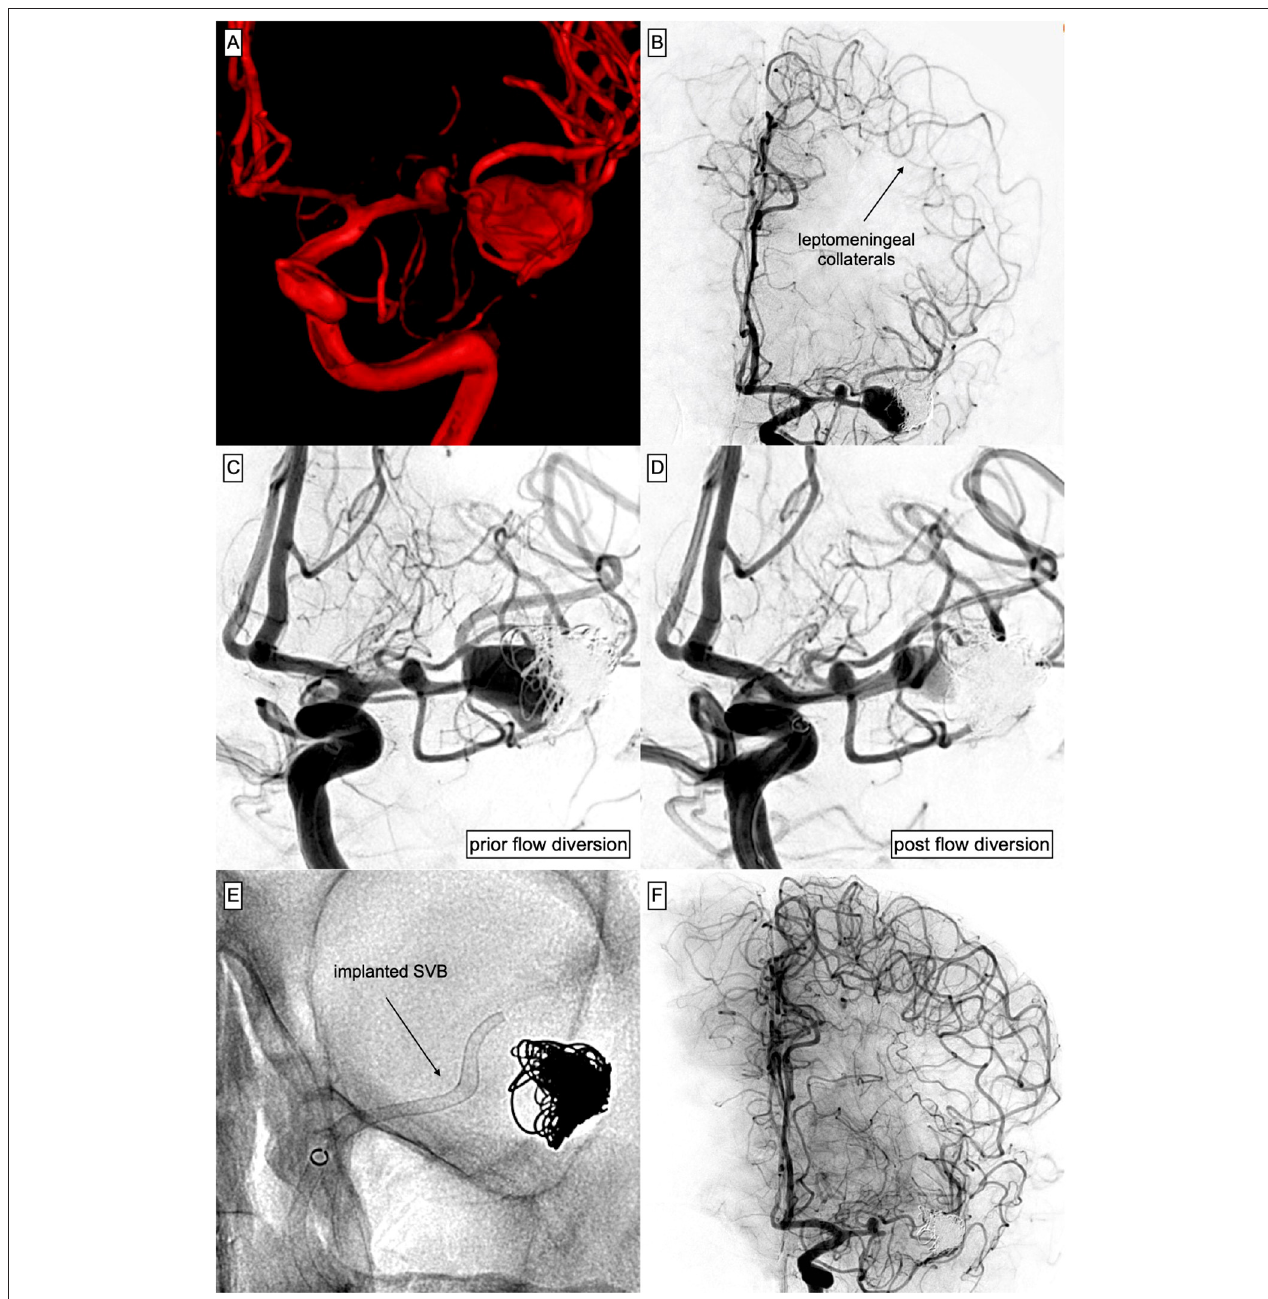
FIGURE 2 | Complex course of a ruptured aneurysm arising from the MCA-bifurcation, treated with Plug & Pipe. (A) 3D reconstruction of the acutely ruptured, complex MCA-bifurcation aneurysm measuring 10mm × 18mm. (B) DSA 3 weeks after protective coiling of the ruptured aneurysm aiming for fundus protection and preservation of the bifurcation. Note the distinct ACA–MCA collaterals that had developed with SAH-associated subacute vasospasm. (C) Aneurysm after coiling, prior TO SVB implantation. Also note the coincidental aneurysm arising from the M1 segment and the stenosis preceding the aneurysmal orifice. (D) Control injection after implantation of the SVB [ (E) shows the corresponding radiograph] into the MCA. The device covers the proximal M1 aneurysm and extends into the superior branch of the bifurcation, significantly reducing aneurysmal inflow. (E) Non-enhanced radiograph corresponding to (D) . (F) Three days after SVB implantation, the patient had developed a subtle right-sided facial paresis and fluctuating aphasia. Immediate DSA revealed no opacification of the distal MCA including the bifurcation-aneurysm but patency of the proximal SVB including the coincidental M1 aneurysm and a temporal MCA branch arising from the aneurysm base. However, ACA–MCA collaterals completely supplied the peripheral MCA territory distal to the occluded segment. A significant perfusion gradient between the proximal M1 segment and the stenotic pre-bifurcation segment had developed, which culminated in the manifestation of a distinct watershed zone after SVB implantation. Blood pressure was raised and the neurological deficit ceased subsequently. The patient had recovered completely after 48h.